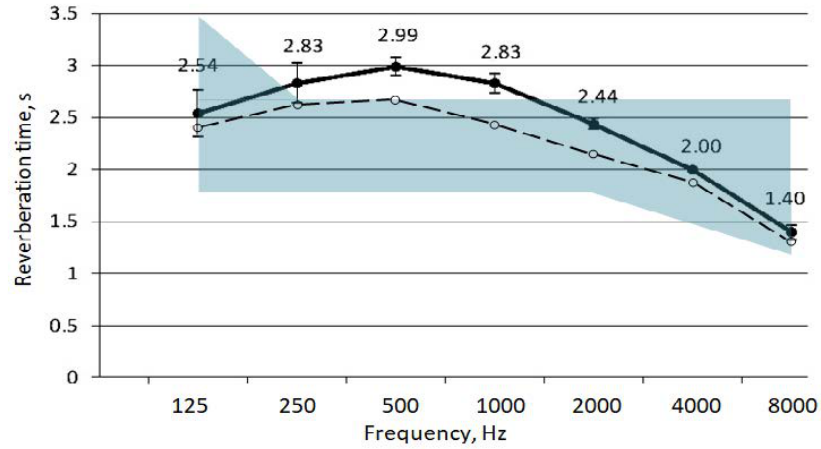
Figure 8. The reverberation time of the winter garden. Continuous line and numerical values: acoustical measurements (the average of 8 observation points, room without public). Measurements were made in accordance with the ISO 3382-2 standard [22], sound source—pistol shot. Dashed line—reverberation time taking into account the presence of the audience, choir and orchestra, see Appendix A. The range of recommended values of reverberation time for the occupied room is marked in blue